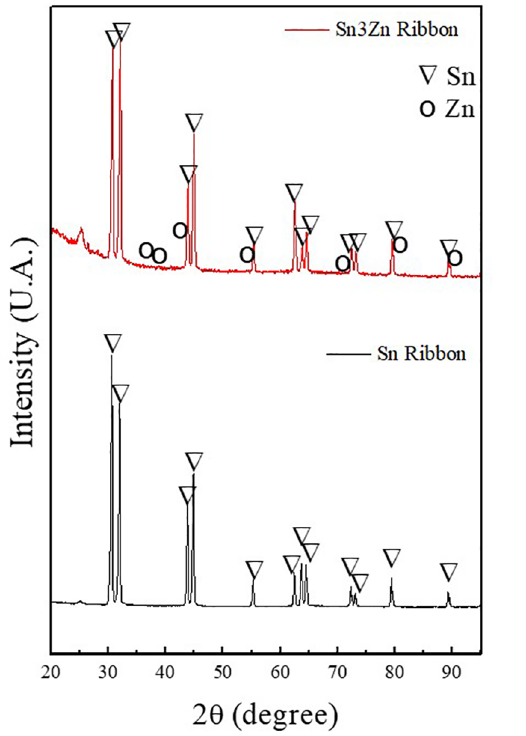
Figure 3. X-ray Diffractograms of (black) Sn ribbons and (red) Sn3Zn ribbons.